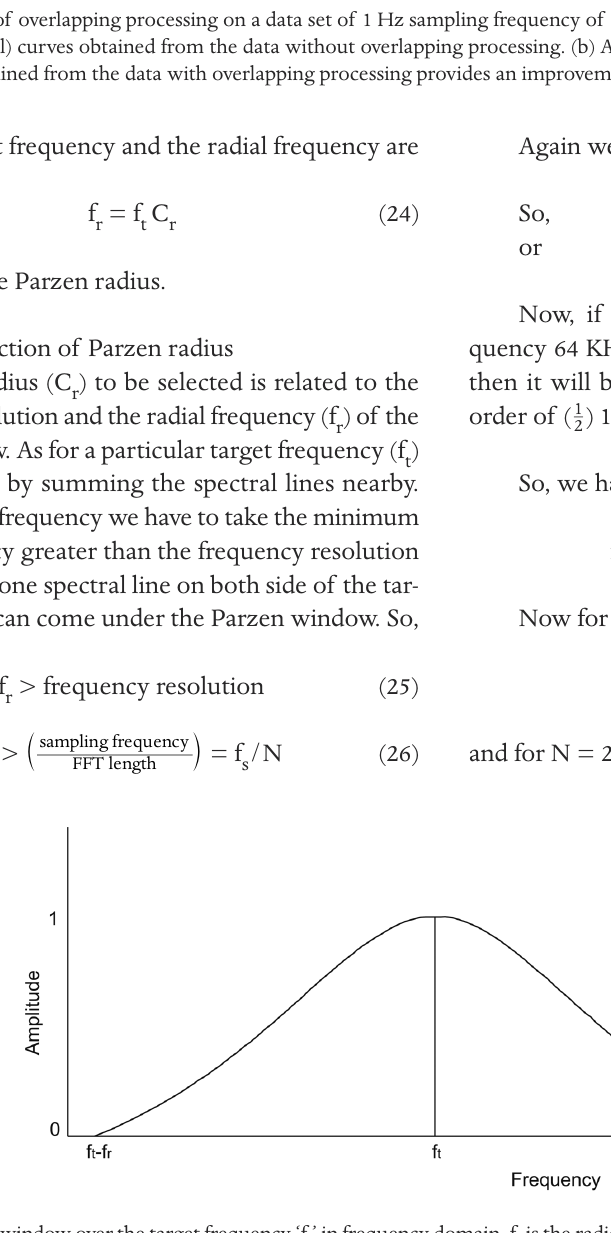
Figure 19. Parzen window over the target frequency ‘f